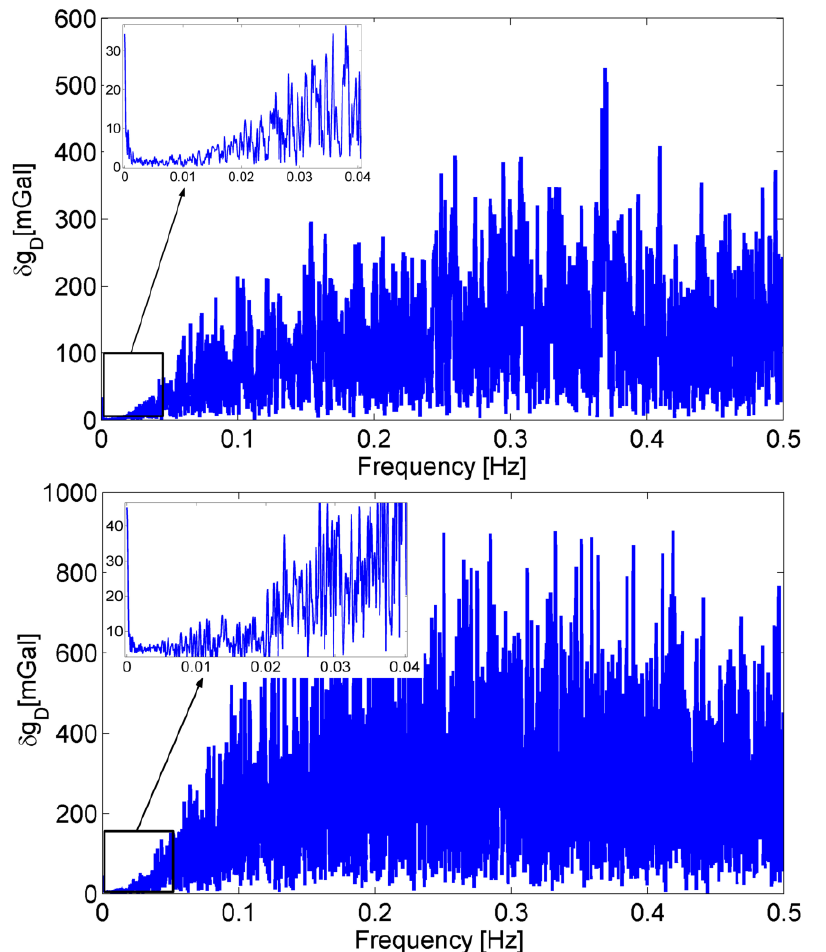
Figure 6. Power spectrum of the raw gravity disturbance of repeated profile A ( top ) and B ( bottom ). The noise distributes in a wide range of